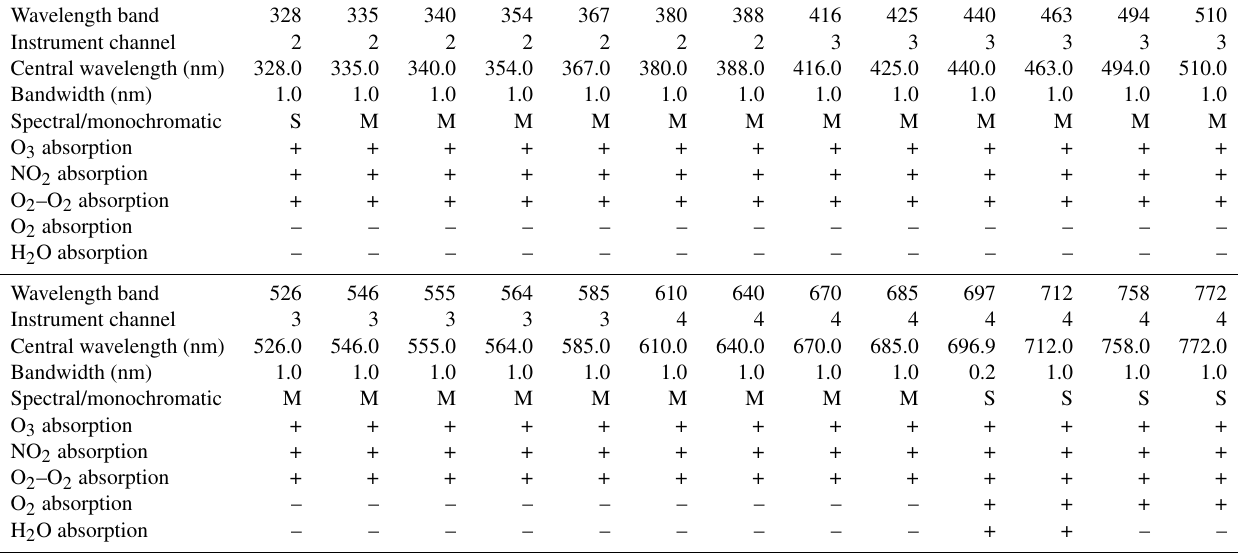
Table 1. Definition of the wavelength bands and details of the radiative transfer calculations for atmospheric correction. Wavelength